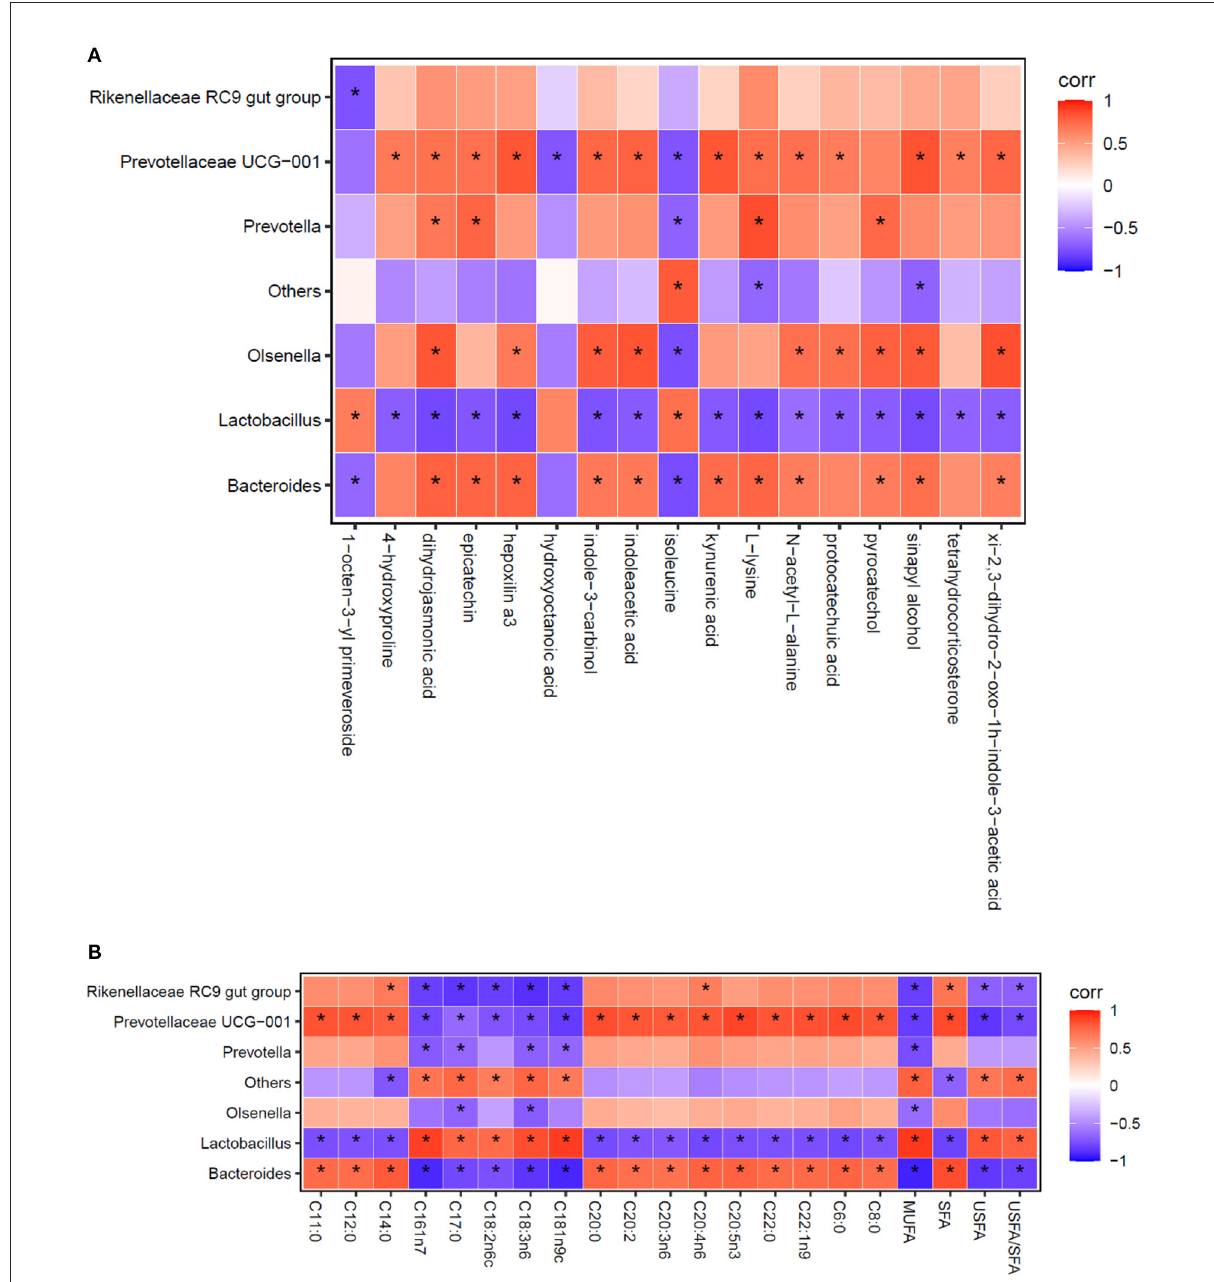
FIGURE2 Spearman correlation analysis between the relative abundance of the most abundant cecal microbes at the genus level and cecal metabolites (A) , as well as the composition of fatty acid in breast muscles (B) . Each column represents a differential metabolite (A) or fatty acid (B) , each row represents a genus, and each square represents a correlation coefficient between the corresponding microbiota component and metabolite or fatty acid. The cross-correlation coefficients were normalized in the range of − 1 to 1. Red (1) represent highest values whereas blue ( − 1) represent the lowest values. The asterisk (*) indicates P <